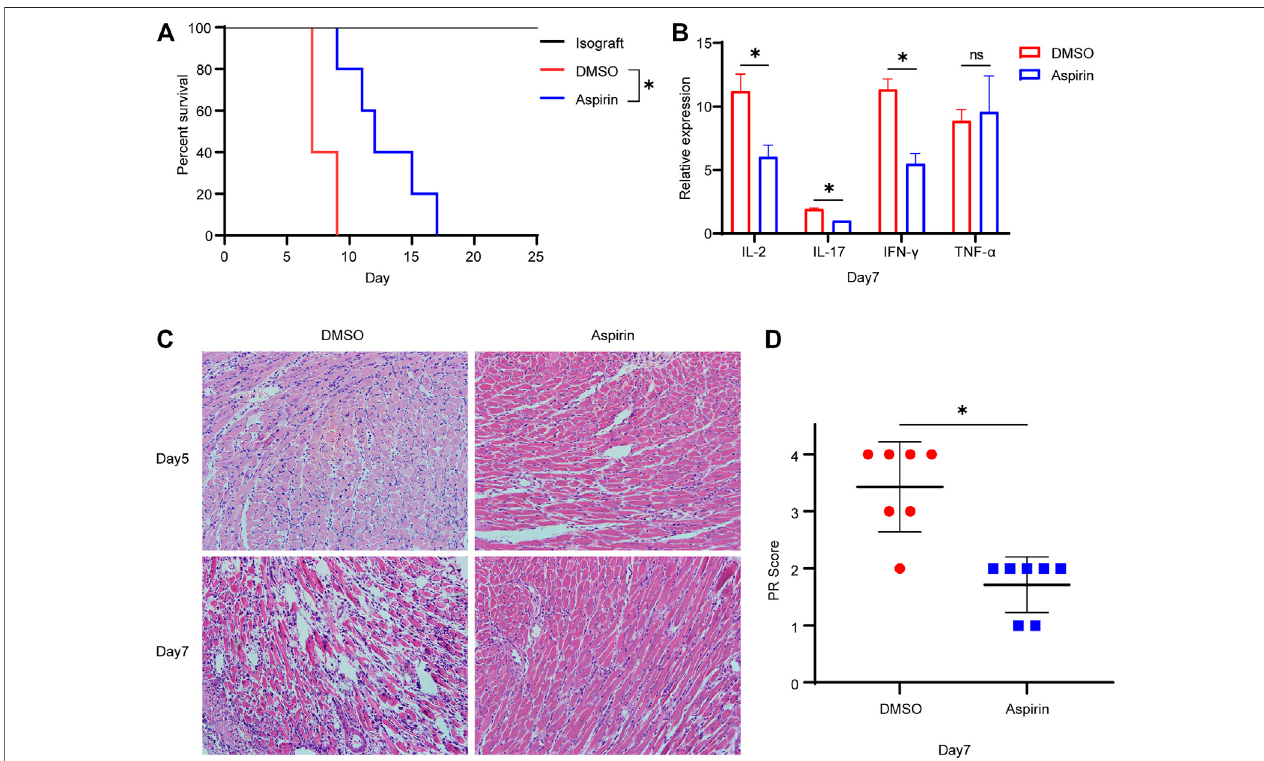
FIGURE 1 | Aspirin prolongs the survival of cardiac allograft in mouse. (A) Establishment of the heterotopic abdominal heart transplantation model with MHC- mismatched mice (BALB/c to B6 mice). From the fi rst day after surgery, recipient mice were intraperitoneally injected with aspirin (200 mg/kg/day). Those receiving DMSO served as control. Aspirin signi fi cantly prolonged the survival of allograft in mouse (MST, 12.8 ± 1.4 versus 7.8 ± 0.5 days, n (cid:2) 5 per group, p < 0.05). (B) On seventhdayaftertransplantation,totalRNAwasextractedfromcardiacallograftandreverse-transcribedintocDNA.TranscriptionallevelsofIL-2,IL-17,IFN- γ ,and TNF- α relative to GAPDH were detected by real-time PCR. (C) Cardiac allografts were harvested on the fi fth and the seventh day after transplantation, tissue sections weremade, andhematoxylin – eosinstainingwasperformed( × 40, n (cid:2) 7per group). Inthe aspirin-treatedgroup, thein fl ammatoryin fi ltration inthemyocardialinterstitium and perivascular area was signi fi cantly inhibited, and the degree of myocardial cell necrosis was reduced. (D) The PR score was performed on tissue sections of each group on the seventh day after transplantation ( n (cid:2) 7 per group). * p < 0.05. DMSO, dimethyl sulfoxide; MST, mean survival time; GAPDH, glyceraldehyde-3-phosphate dehydrogenase; IFN, interferon; IL, interleukin; TNF, tumor necrosis factor; PR, parenchymal rejection.